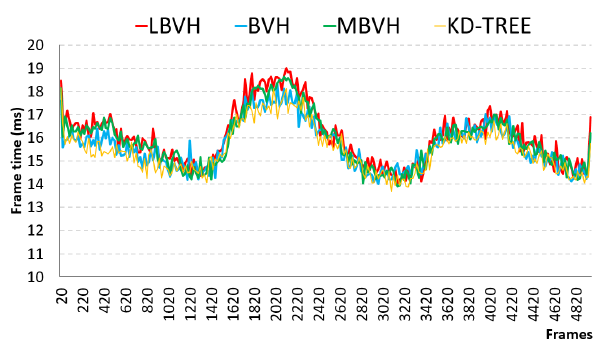
Fig. 5. Comparison of different acceleration data structures for reflections of static models in the walkthrough animation.